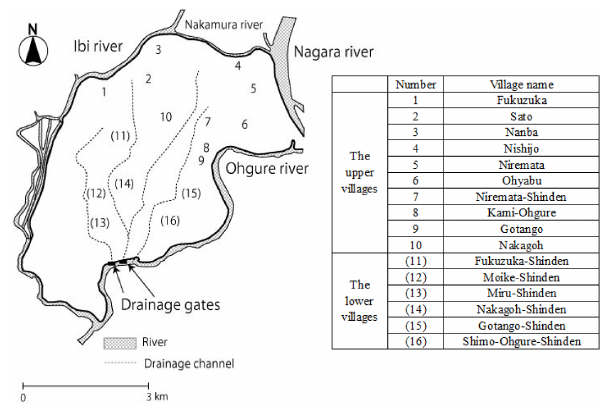
Figure 2. Lower villages are shown by numbers with parentheses. (Based on a map provided by an Editorial committee of a history of Wanouchi town,